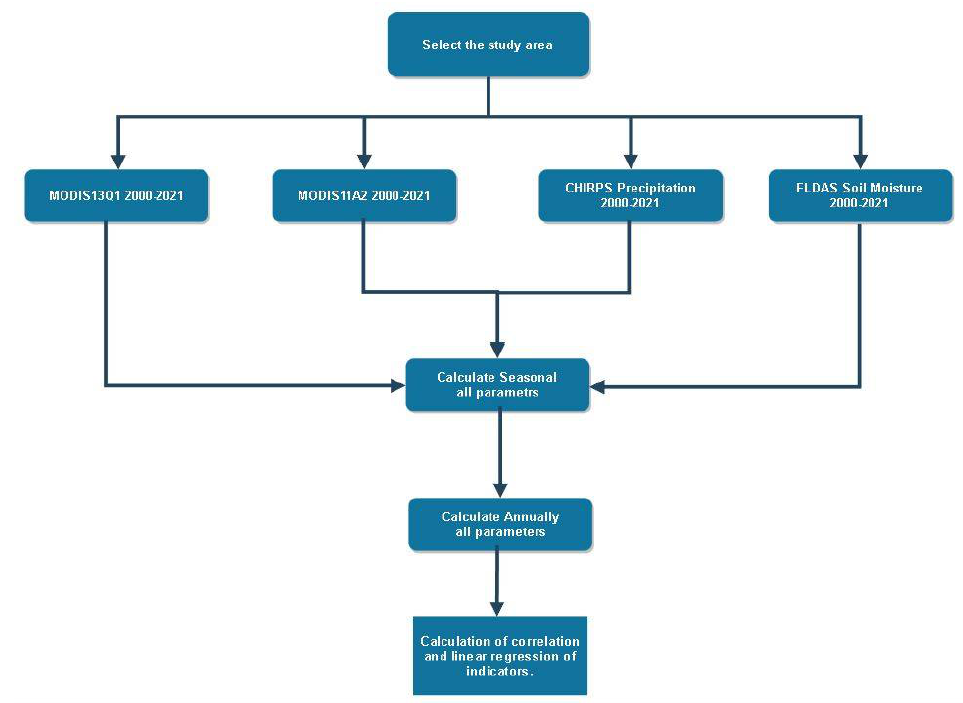
Figure 2. Flowchart of the data processing.